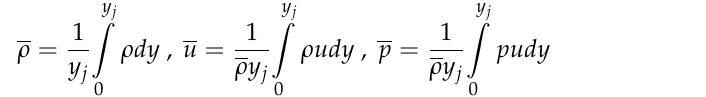
and ‐ dot lines). Figure 15. Soot ‐ oil coating on the surface of the outer wide disc at 0.15 mm h  .